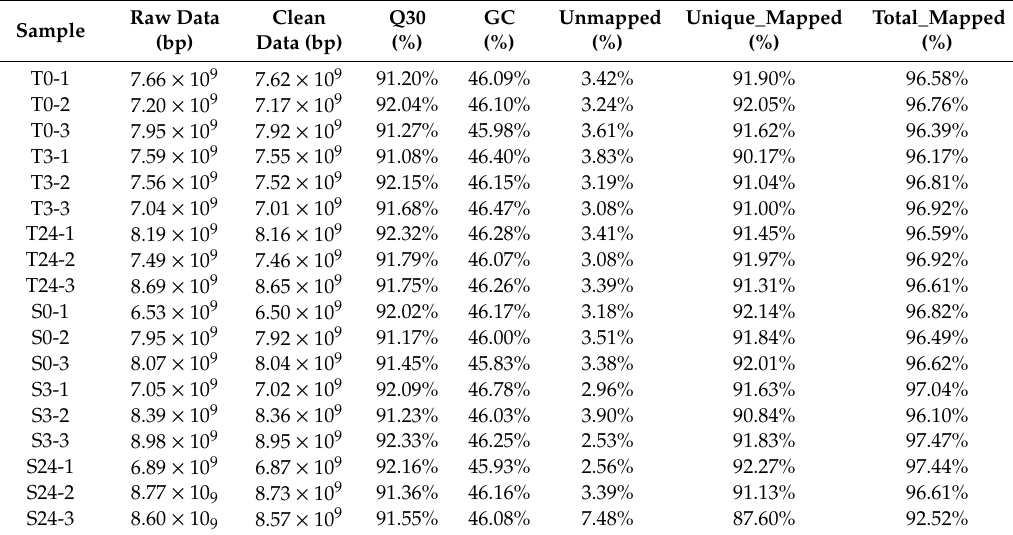
Table 1. Summary of sequencing data for di ff erent